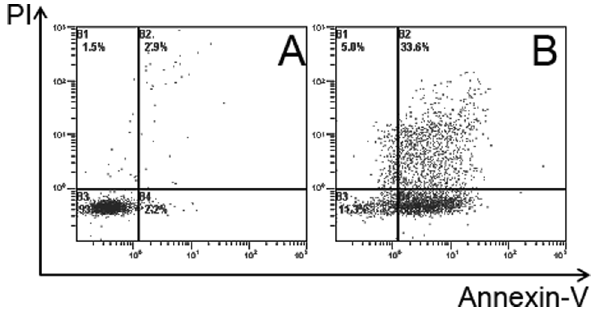
Figure 5. Apoptosis/necrosis of tumor cells induced by gamma- irradiation and electro-fusion. After undergoing irradiation and electro-fusion, tumor cell (from patient1) apoptosis/necrosis was assessed using the Annexin-V /PI analysis. A, Apoptosis/necrosis analysis of tumor cells without irradiation and electro-fusion. No significant apoptosis or necrosis was observed. B , Tumor cells (33.6%) developed apoptosis/necrosis after gamma-irradiation and electro-fusion. Early apoptotic cells were defined as annexin V-FITC + /PI 2 , while necrotic cells were double-positive.